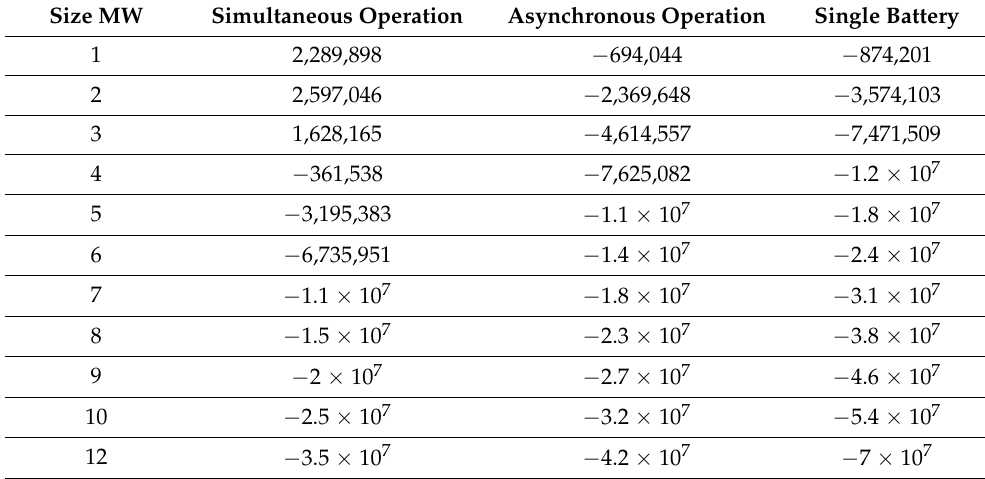
Table 4. Operation profit of BESS integrated WF (OPB) with various battery capacities in (ETB).